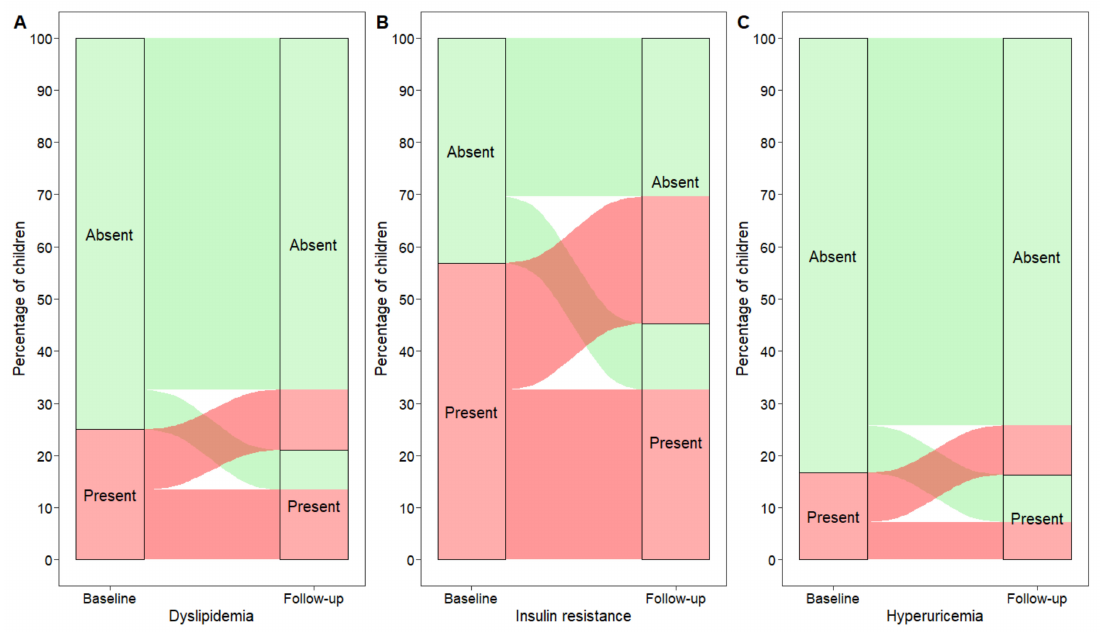
Figure 2. Graphical representation of subjects moving from a pathological to a normal clinical condition and vice versa (( A ) Dyslipidemia; ( B ) Insulin resistance; ( C ) Hyperuricemia), from baseline to follow-up. Table 2. Effect of LDL, HDL or triglycerides at baseline, gender, transition from pre-pubescent to pubescent, BMI or WtHr, family history of dyslipidemia on LDL, HDL or triglycerides at follow-up, by multiple linear regression models. Effect of dyslipidemia at baseline, gender, transition from pre- pubescent to pubescent, BMI or WtHr, family history of dyslipidemia on dyslipidemia at follow-up, by a multiple logistic regression